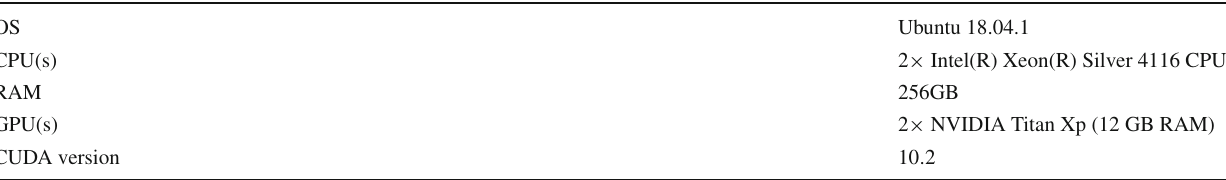
Table 2 Specifications of the machine used to perform the experiments with Falkon OS Ubuntu